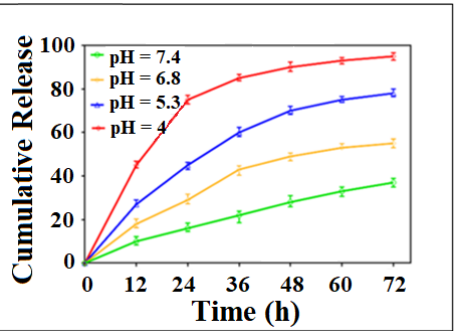
Figure 8. Cumulative release of 5-FU from 5-FU-loaded FOLA@NH 2 -Eu:TMU62. Reproduced with permission from Ref. [175]. Copyright © 2019, American Chemical Society.